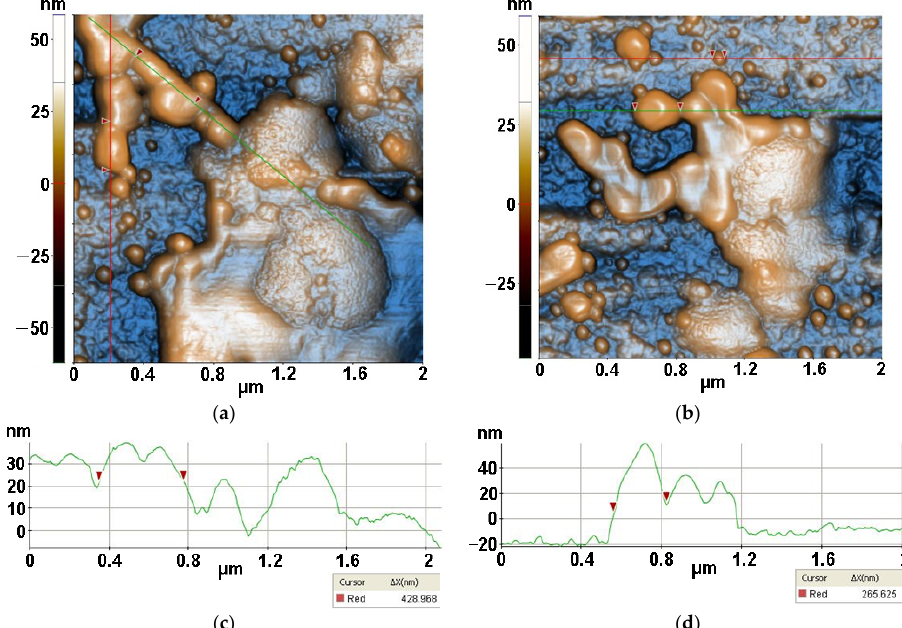
Figure 14. Two-dimensional AFM images of S. aureus (from inoculum) with ZnSe-TiO 2 deposited on glass substrate, after 30 min of irradiation, recorded in two areas at the scale of (2 μ m × 2 μ m) ( a , b ), with two characteristic surface profiles ( c , d ).